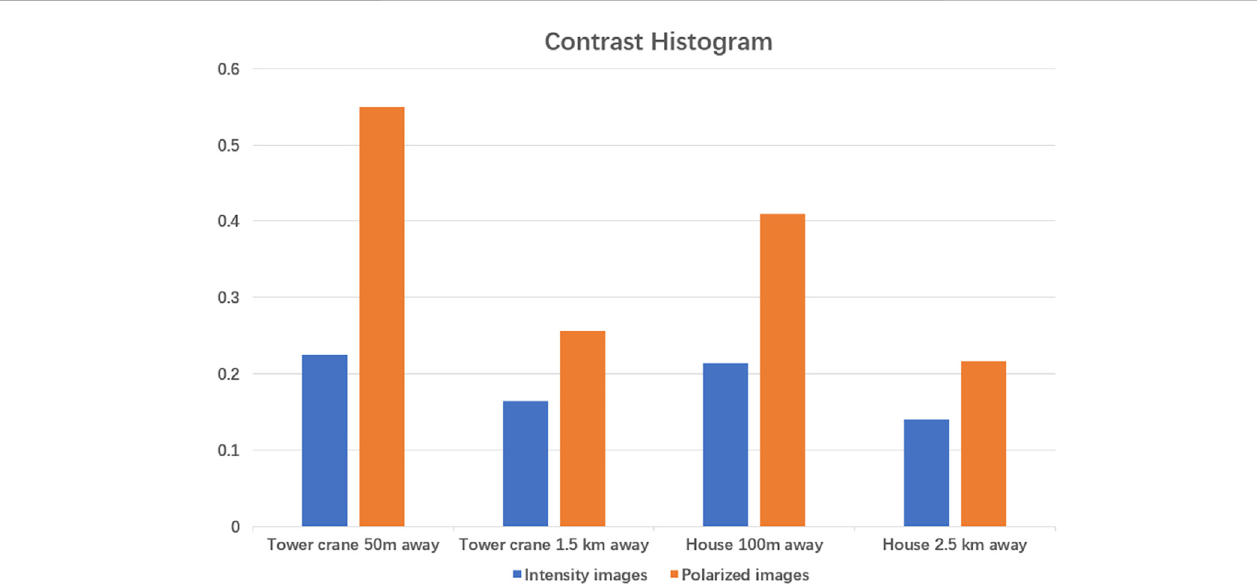
FIGURE 12 Histogram of contrast between images with different imaging distance intensity and polarized